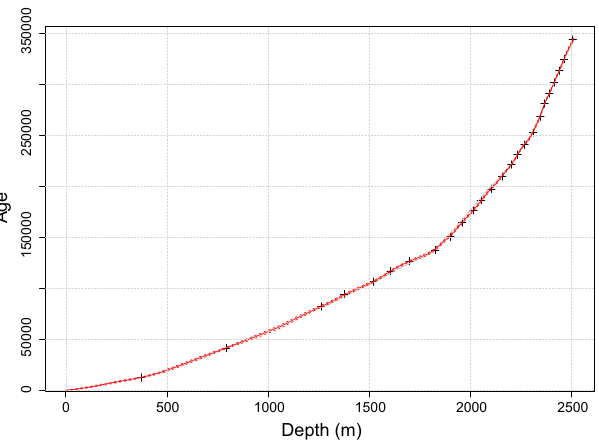
Figure 4. Estimated age as a function of depth. The solid line in- dicates the median of the posterior distribution. The 10th and 90th percentiles of the posterior are indicated by red dotted lines. The black crosses indicate the tie points. The result obtained by Parrenin et al. (2007) is also indicated by a grey line.